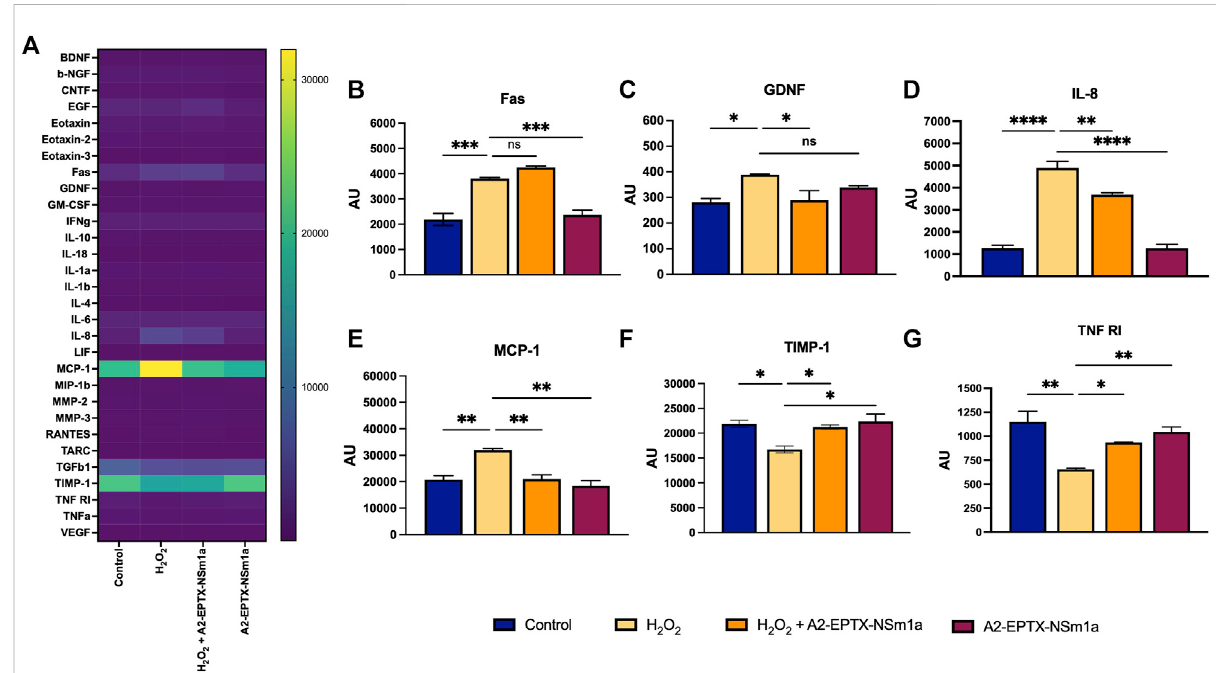
FIGURE 6 A2-EPTX-NSma1 effects on the neuro-markers expression levels in the differentiated SH-SY5Y with and without oxidative stress conditions. The expression level of proteins was analysed using normalized signals extracted from Agilent Feature Extraction software. Values are collected from quadruplicates of a speci fi c protein and expressed as mean ± standard deviation ( n = 3). Protein expression is considered as signi fi cant as compared to the H 2 O 2 group with p < 0.05 based on statistical analysis using one-way ANOVA followed by Tukey ’ spost-test. ns as signi fi cant, * p < 0.05, ** p < 0.01, *** p < 0.005, **** p <